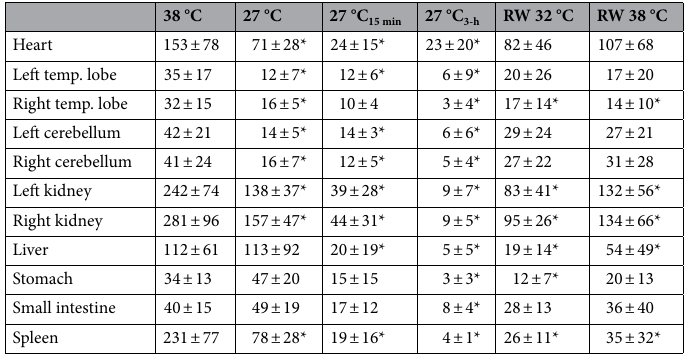
to 27 °C, blood flow to the stomach and small intestine increased by + 38% and + 23%, respectively (Fig. 3D). However, after 3-h of CPR, blood flow to the stomach and small intestine was severely reduced by − 90% and − 79% of baseline, respectively. Cooling to 27 °C significantly reduced blood flow to the right (− 44%) and left (− 43%) kidneys (Fig. 3E), and renal blood flow was almost completely shut off after 3-h of CPR (− 97%, and − 96%, respectively). Liver blood flow was unaltered after cooling to 27 °C, whereas blood flow to the spleen was reduced (− 66%) (Fig. 3F). Both organs had severely impaired blood flow during CPR, and after 3-h, blood flow was reduced by − 97% in the liver and − 99% in the spleen compared to baseline at 38 °C. ECMO rewarming. The mean time required to rewarm blood temperature to 32 °C was 17 min with an additional 45 min to rewarm blood temperature to 38 °C. Ringer acetate was added to the ECMO circuit to maintain venous access pressure above − 100 mmHg. Return of cardiac rhythm. All 8 pigs achieved sinus rhythm on ECMO, one spontaneously at 29 °C, two after cardioversion at 32 °C, and two after cardioversion at 38 °C. Three animals resumed a sinus rhythm only after sternotomy and pericardiotomy, to evacuate blood congesting in the mediastinum and in pericardium, before internal cardioversion at 38 °C. Blood flow, pressure, and rewarming rate during ECMO. In the ECMO circuit, pump flow rate and MAP (Fig. 1A,B) were adjusted to mimic hemodynamic characteristics of the individual animal during cooling. Sta- tistical comparisons were based on comparisons to individual baseline (38 °C) values. At 27 °C, the circuit was started at a flow of 1 l/min, gradually increased to 2.0–2.5 l/min at 32 °C, and finally 3.0–3.5 l/min at 38 °C. No vasoactive pharmacologic intervention was required to adjust pressure generation during rewarming. In each experiment, total volume of Ringer acetate added varied between 2000 to 6000 ml (mean 3750 ml). O 2 transport and extraction (Fig. 2A–C). Global Ḋ O 2 increased during ECMO rewarming but at 38 °C, it was still significantly reduced compared to baseline (15.2 ± 4.4 vs. 9.4 ± 3.0 ml/min/100 g; − 38%). Similarly, global V ̇ O 2 increased during rewarming, but at 38 °C, it was still reduced compared to baseline (6.8 ± 2.5 vs. 4.3 ± 1.1 ml/min/100 g; − 34%). During rewarming, cerebral Ḋ O 2 and V ̇ O 2 (Fig. 2B) increased, but at 38 °C, they were both still reduced compared to baseline (cerebral Ḋ O at 38 °C, they were unchanged compared to baseline values. After rewarming arterial pH levels (Table 1) returned to baseline, 7.39 ± 0.1 vs. 7.55 ± 0.05. Serum lactate levels (Table 1) were highest at 32 °C (5.8 ± 2.59), fell during rewarming to 38 °C, but were still significantly elevated compared to baseline (5.1 ± 2.62 vs. 0.98 ± 0.68 mmol/l). After rewarming SvO 2 (Table 1) was restored to 60%. Organ blood flow (Fig. 3A–E, Table 2). Rewarming elevated blood flow to all organs, but statistical analyses showed that blood flow returned to baseline in only a few organs. Myocardial blood flow was restored after rewarming. Similarly, blood flow to the left temporal lobe was restored, whereas blood flow to the right temporal lobe was still significantly reduced (− 56%). Rewarming restored blood flow to both cerebellar hemispheres. In most abdominal organs, rewarming only led to partial restoration of blood flow. Blood flow to the stomach and small intestine was restored, whereas, compared to baseline, blood flow remained significantly reduced in the liver (− 52%) and spleen (− 82%). Compared to baseline 38 °C, renal blood flow was significantly reduced after rewarming in both the left (− 45%), and right (− 53%) kidney. Plasma biomarkers (Table 3). Significant (six–tenfold) increase in ASAT appeared after 3-h CPR and remained after rewarming. Also level of glial fibrillary acidic protein (GFAP) was increased after rewarming.